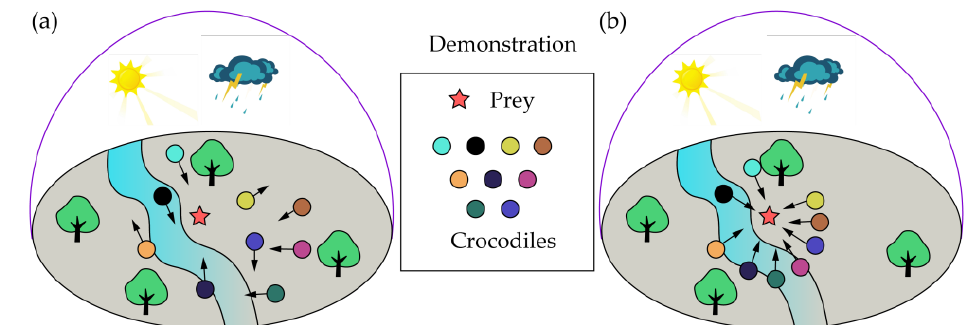
Figure 1. Illustration of hunting behavior for RSA proposed by Abualigah et al. [61]: ( a ) exploration; ( b ) exploitation.